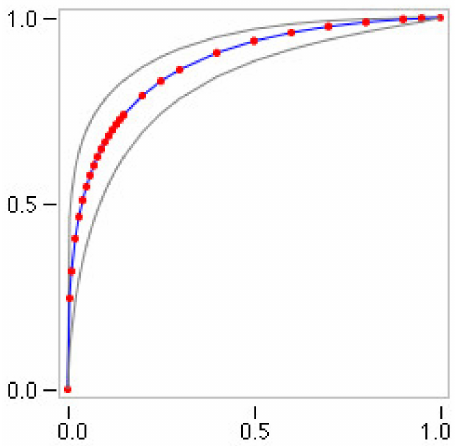
Figure 6. The ROC area of modified validation data: AUC (0.877).